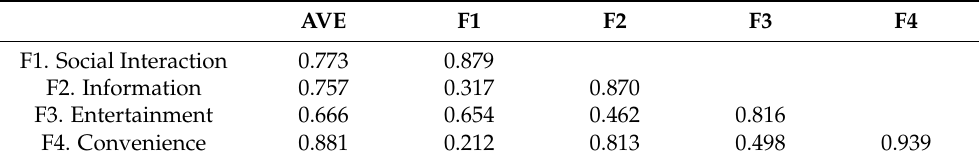
Table 5. Correlations among All Constructs: Level 2